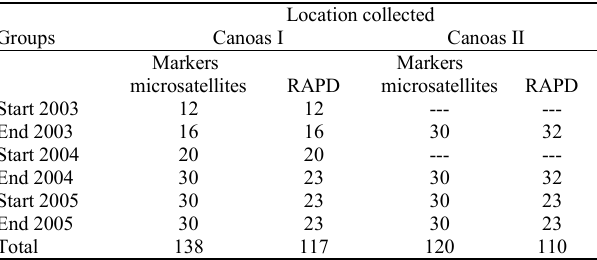
Table 1. Number of specimens analyzed in each sampling group of Leporinus elongatus from the fish passage ladders of HEPs Canoas I and Canoas II. Start: collected from January to March; End: collected from October to